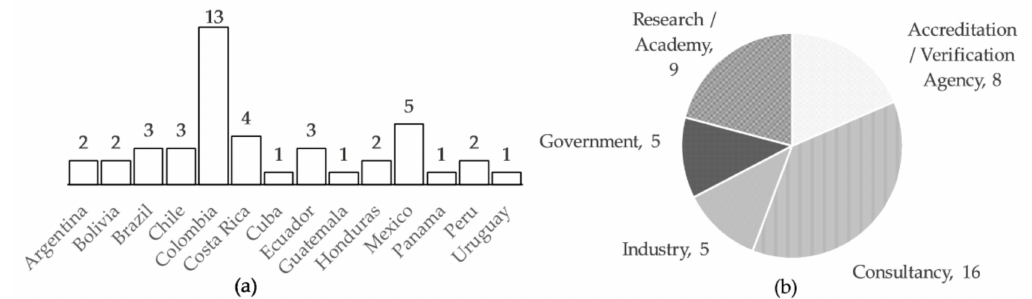
Figure 1. Analysis of the participants in the initiative to elaborate recommendations for the regional coherence of application of the water footprint ISO 14046:2014 ( a ) by country; ( b ) by type of institution. The numbers shown represent the number of people in each case.